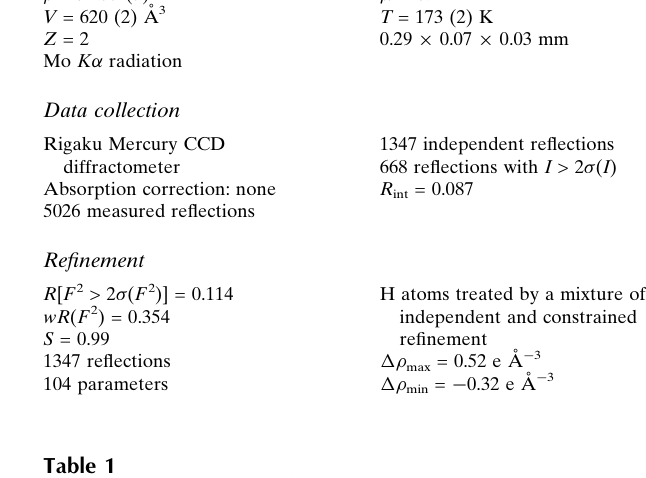
Hydrogen-bond geometry (A˚ , (cid:2)